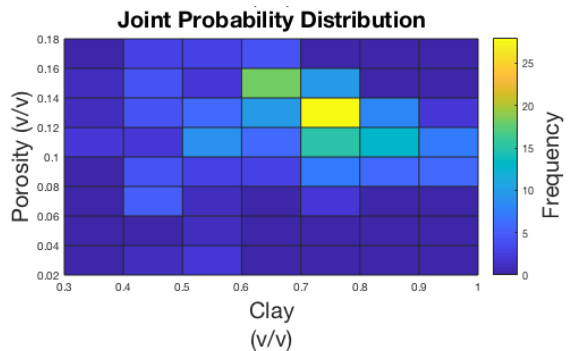
Figure 8. Joint probability distribution of measured porosity and clay for the well in the Permian Basin. Inversion is performed separately for the quartz rich zone and the calcite rich zone. The quartz rich zone, which has more clay shows a decrease in porosity with increasing clay content, indicating clay may be pore-filling. The quartz rich zone has higher porosity than the calcite rich zone, which reflects a combination of the effect of less calcite cement and more quartz.